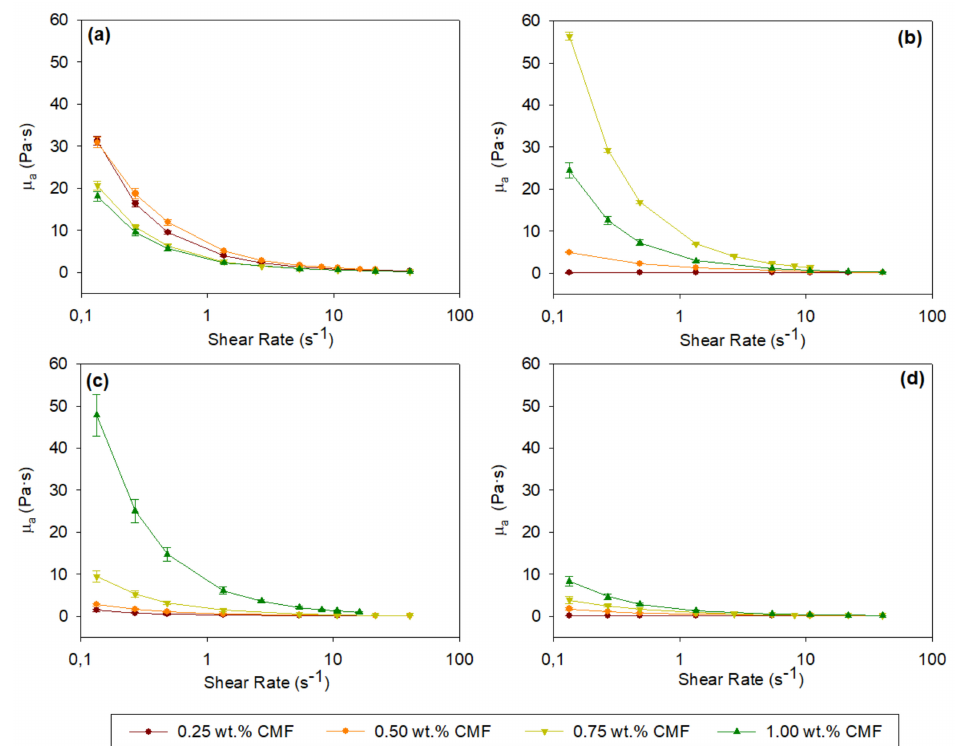
Figure 6. Effect of CMF dose on apparent viscosity for emulsions with different O/W ratio: ( a ) 40/60, ( b ) 50/50, ( c ) 60/40, and ( d ) 70/30.